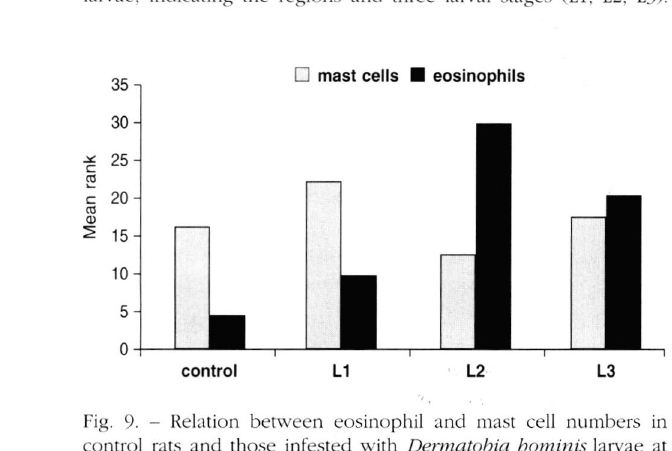
Fig. 8. - Histogram representing mean rank values of mast cells in skin of control rats and those infested with Dermatobta homints larvae, indicating the regions and three larval stages (LI. L2. L3).